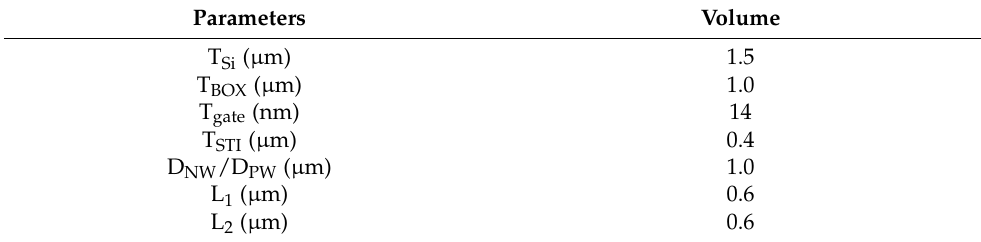
Table 1. Some parameters of